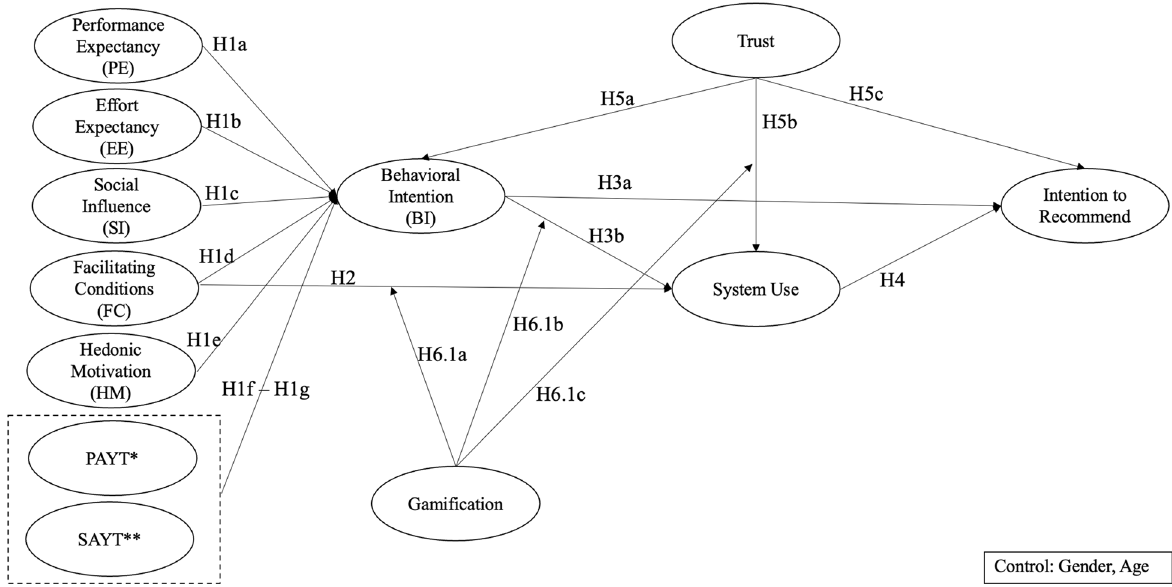
Fig. 1 Research model. Note: *PAYT – pay-as-you-throw,